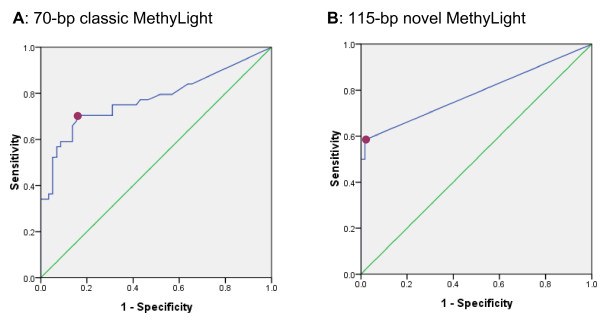
ROC curves of detection of methylated-p16 by two MethyLight assays. The sensitivity and specificity of the MethyLight assay at various points of relative copy number in 102 tested samples were calculated according to the result of the 150-bp MSP. The cut-off points of RCN were marked by the deep-red circlets. A: For the 70-bp classic MethyLight, the area under the curve is 0.776 (95% CI: 0.677-0.874), P = 0.000. When the cut-off point of RCN was 0.0725, the sensitivity and specificity were 0.705 and 0.845, respectively. B: For the 115-bp novel MethyLight assay, the area under the curve is 0.787 (95% CI: 0.689-0.884), P = 0.000. When the cut-off point of RCN was 0.0002, the sensitivity and specificity were 0.591 and 0.983, respectively.